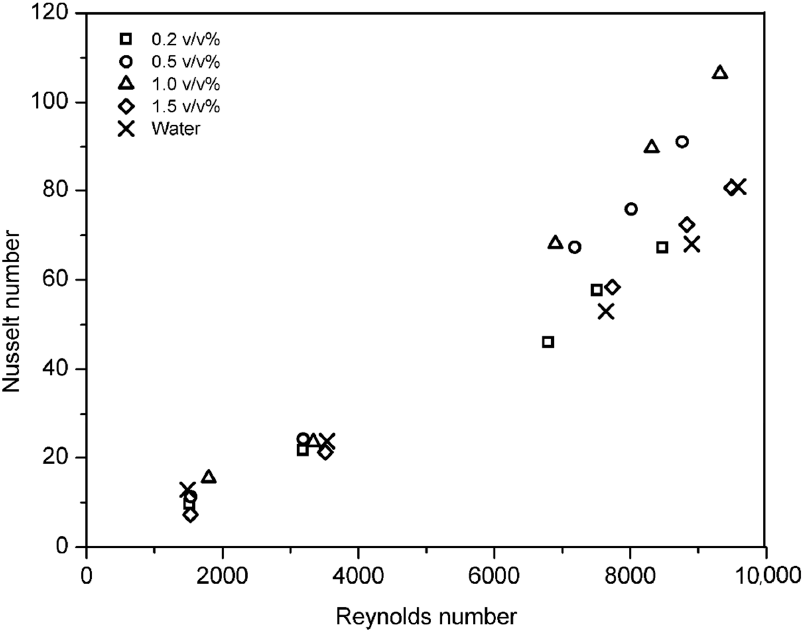
Figure 10. Experimental N Nu versus N Re in water and TiO 2 –W NFs.